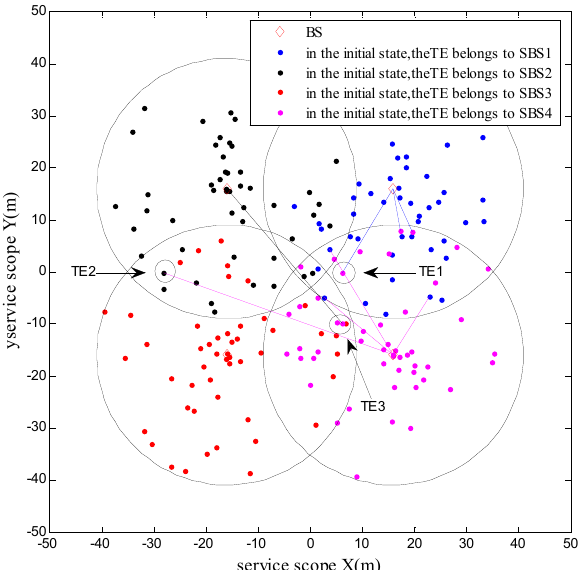
Figure 3. Terminal equipment allocation after minimum cost algorithm based on energy decision under K = 200.